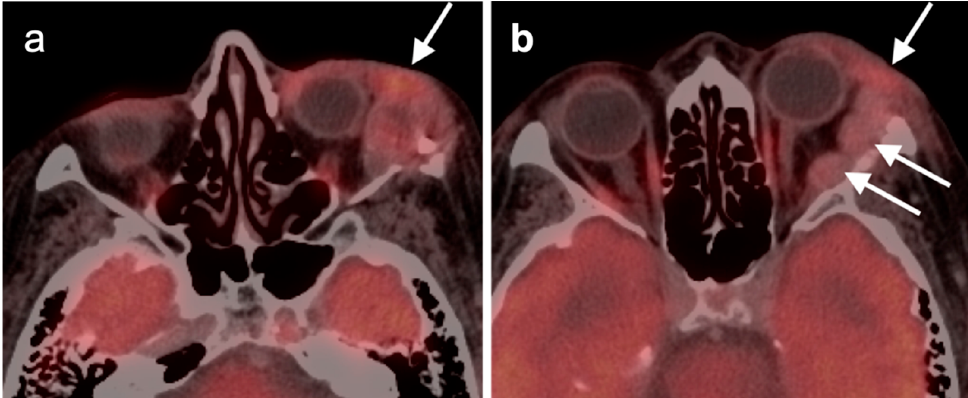
Figure 26. Carcinoma ex ‐ pleomorphic adenoma (CXPA) of the lacrimal gland. ( a ) CXPA of the left lacrimal gland is mildly hypermetabolic (white arrows). ( b ) Tumor extends intraorbitally along the lateral orbital wall with medial displacement of the orbital contents.